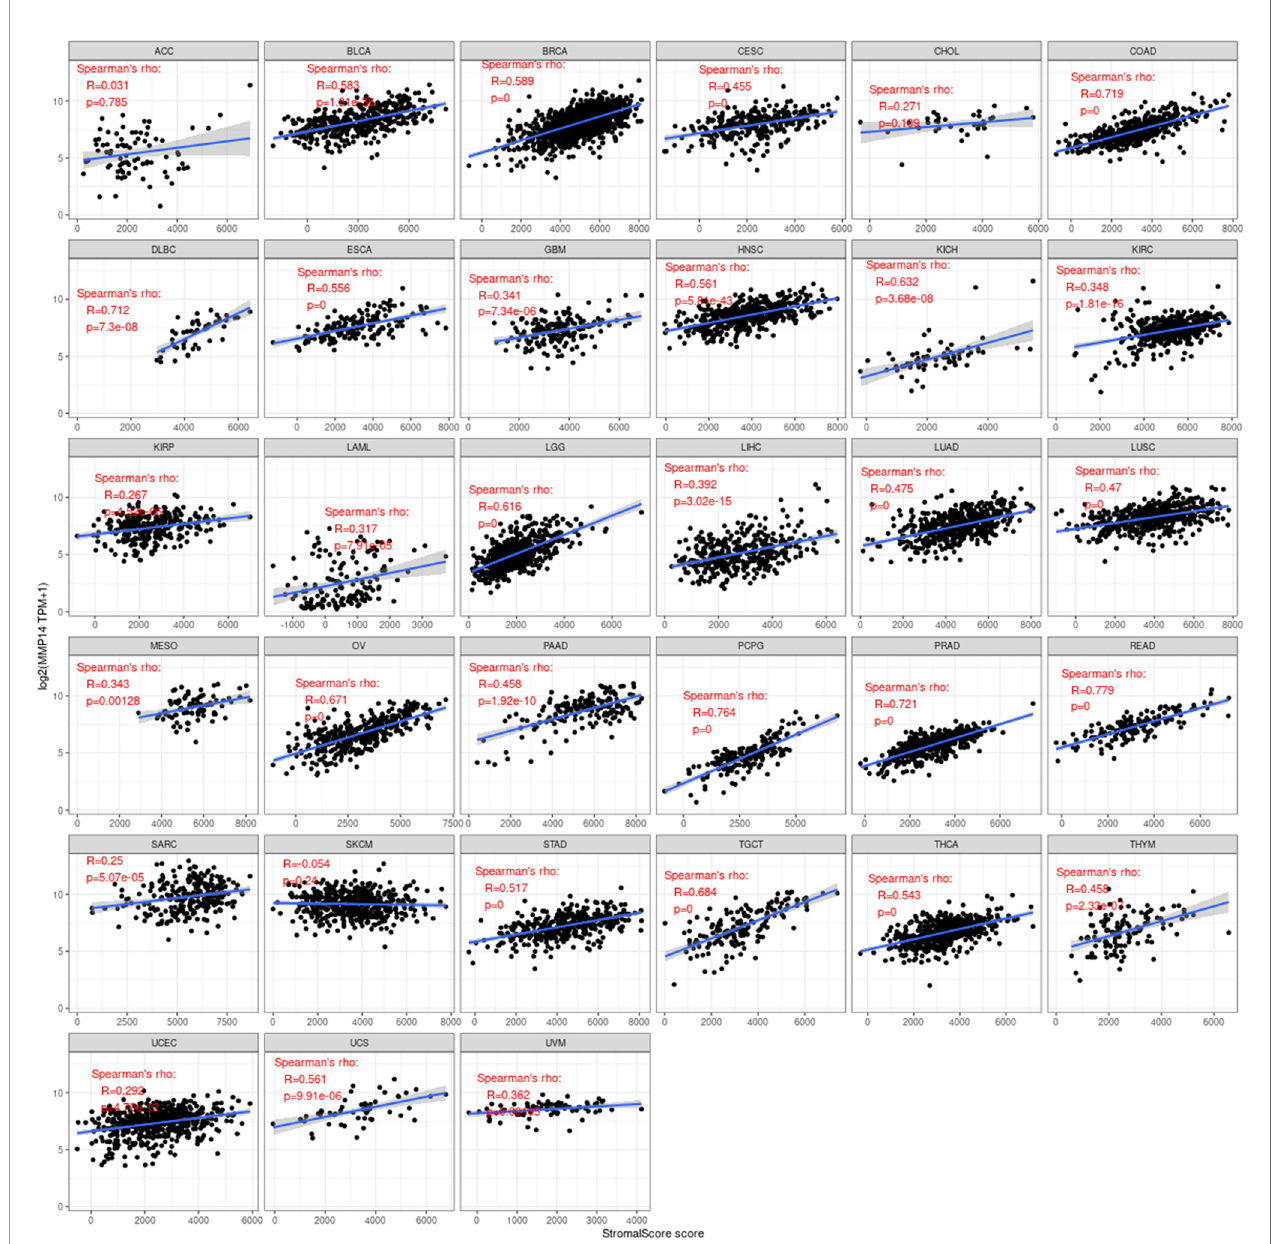
FIGURE 7 | Relationship between the expression of matrix metalloproteinase 14 (MMP14) and immune score in pan-cancer. Only in adrenocortical carcinoma (ACC), skin cutaneous melanoma (SKCM), testicular germ cell tumor (TGCT), and thymoma (THYM) was the expression of MMP14 negatively correlated with immune cell in fi ltration, and the others were positively correlated with immune cell in fi ltration (in the case of p <